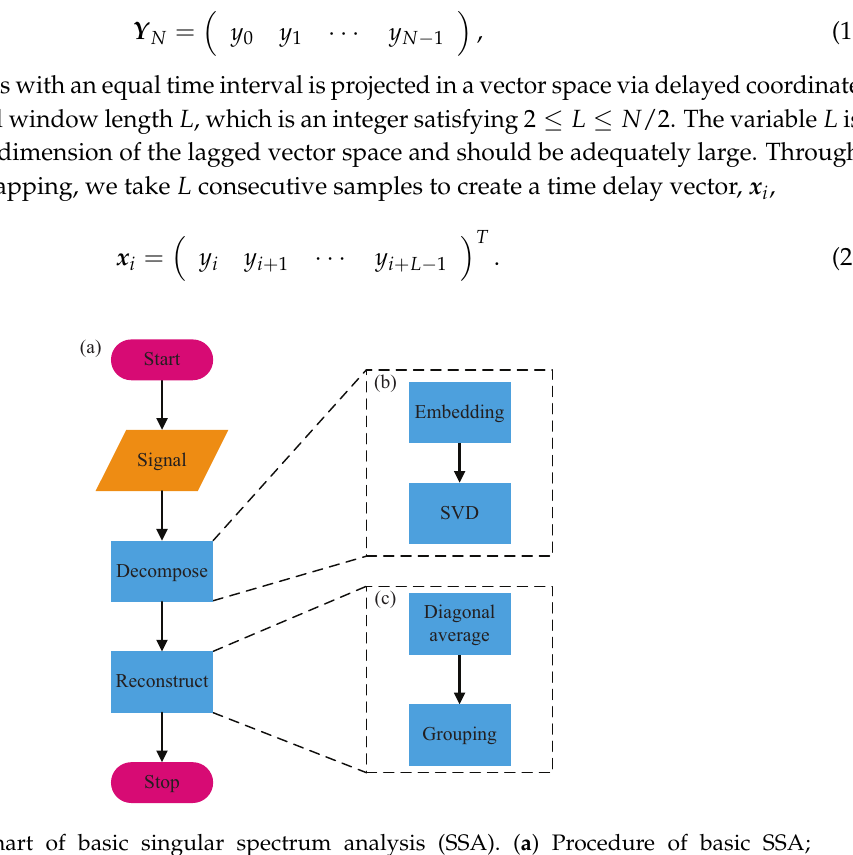
Figure 1. Flowchart of basic singular spectrum analysis (SSA). ( a ) Procedure of basic SSA; ( b ) sub-procedure: decomposition; ( c ) sub-procedure: